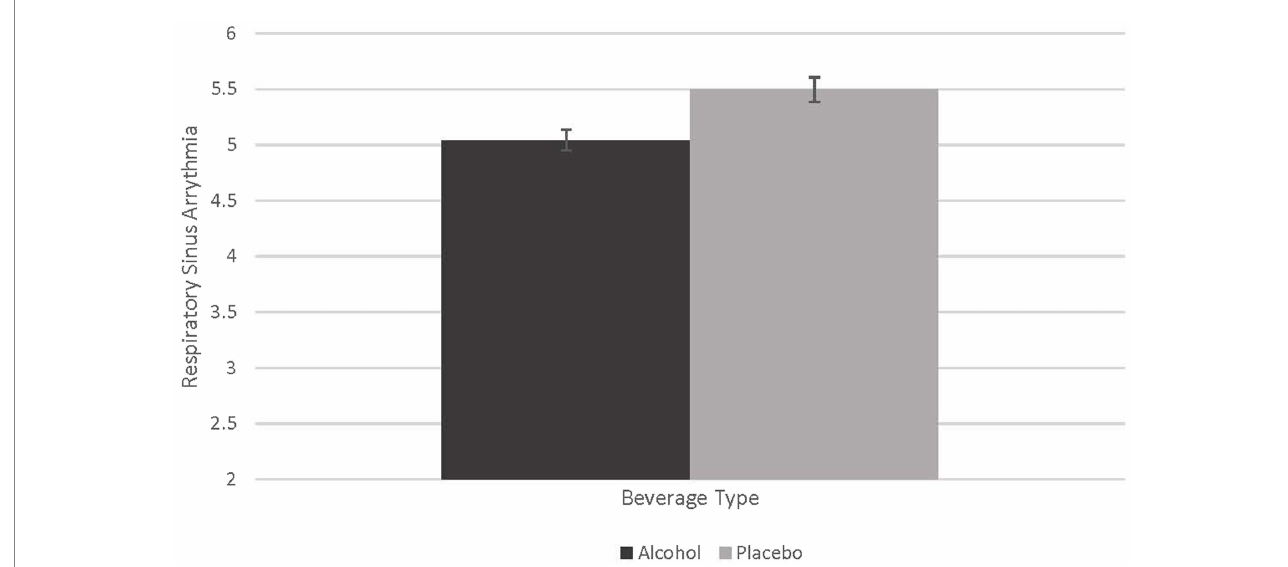
FIGURE 1 Effect of alcohol on respiratory sinus arrythmia. This figure demonstrates the marginally significant difference in beverage type on respiratory sinus arrythmia (RSA; F = 4.077, p = 0.51, partial eta squared = 0.102).